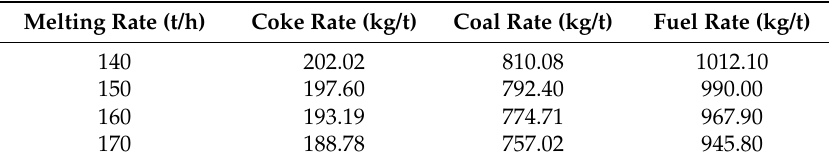
Figure 4. The variation trend of fuel rate with the melting rate. Table 1. Fuel structure under different melting rates.